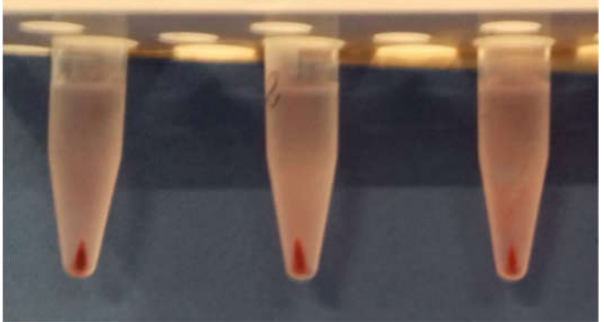
Figure 9. Photograph of centrifuged samples (10 wt.% Dox·HCl polymersomes dispersion).